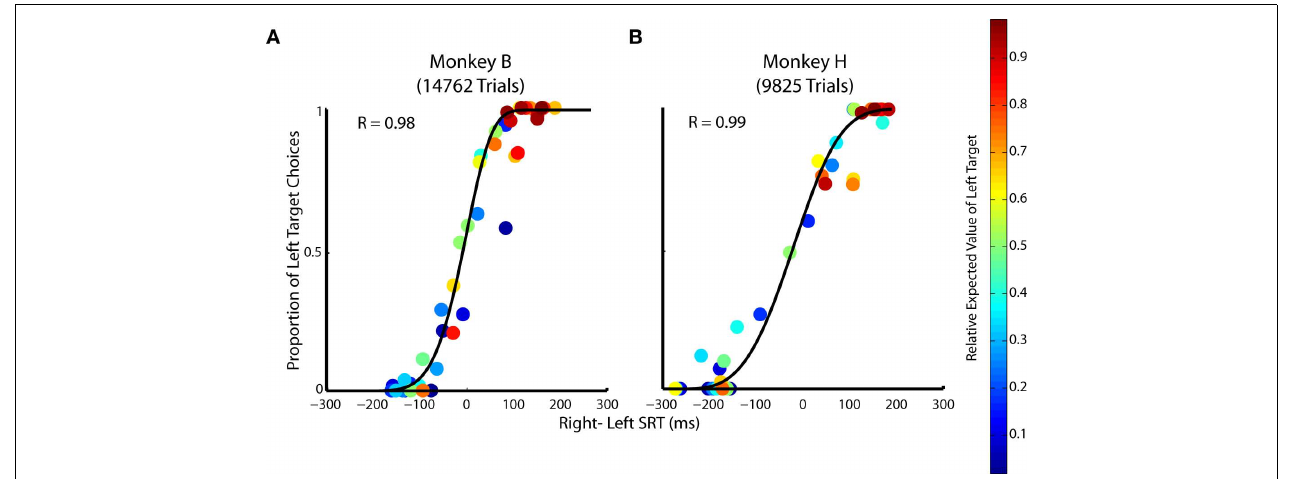
all 49 prospects. Each point represents ∼ 300 trials in Monkey B and ∼ 200 trials in Monkey H of a specific prospect whose relative expected value is indicated by the heat map legend on the